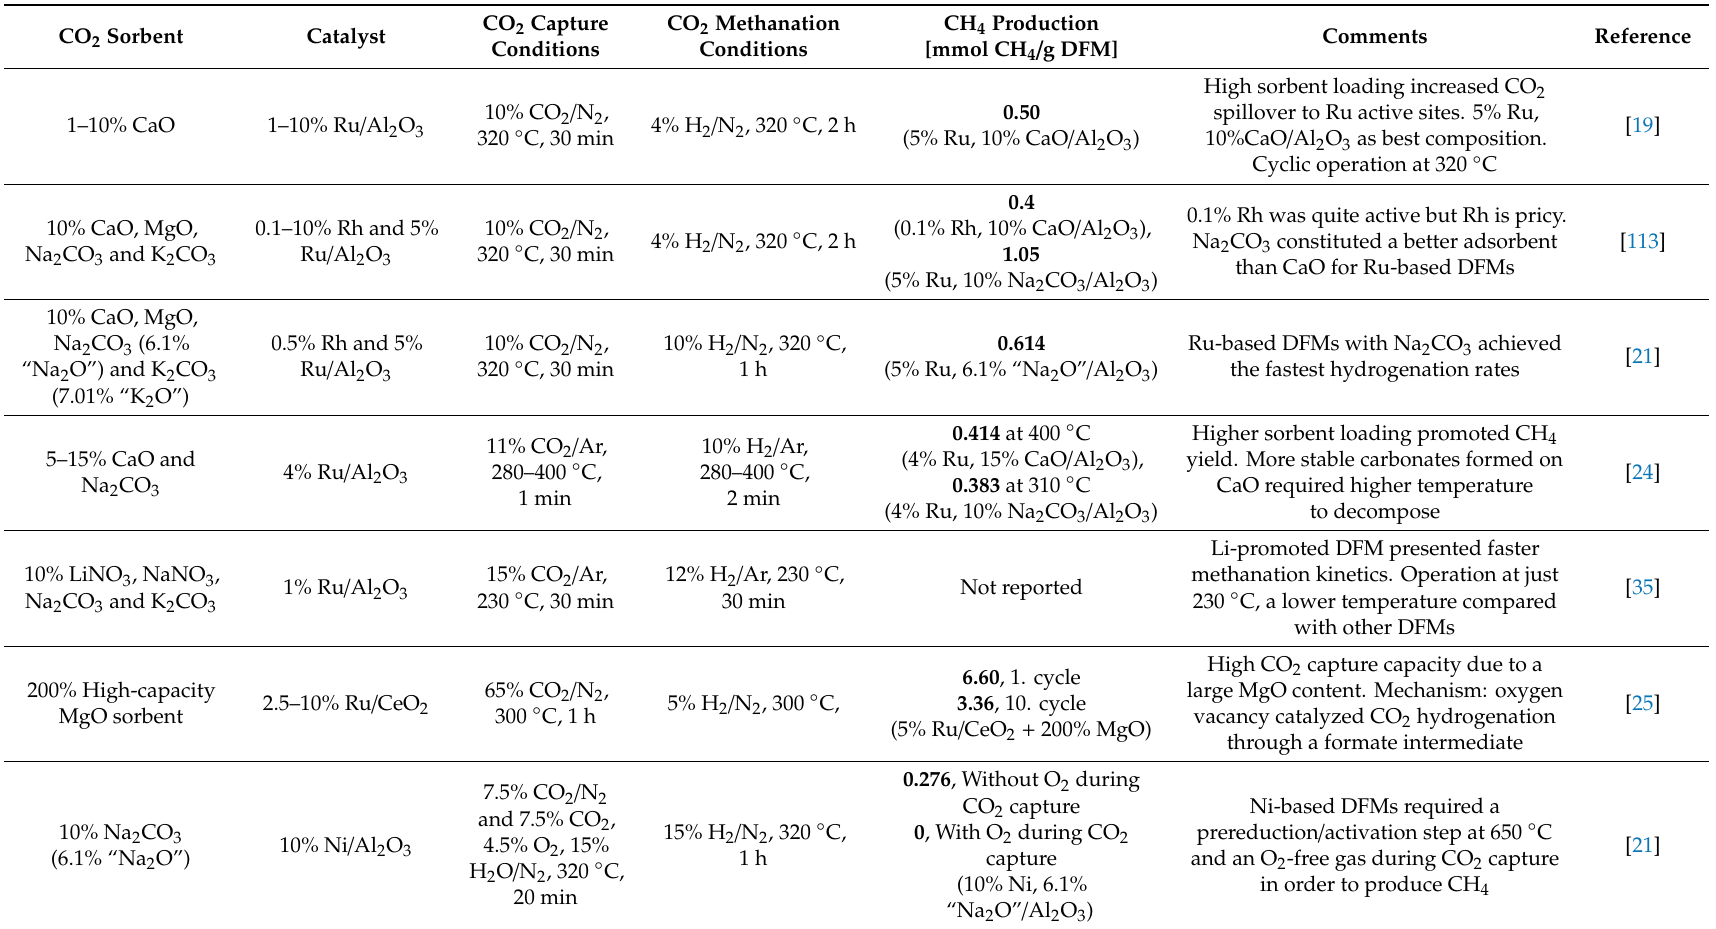
Table 2. Summary of dual-function materials (DFMs) employed in the combined CO 2 capture and methanation